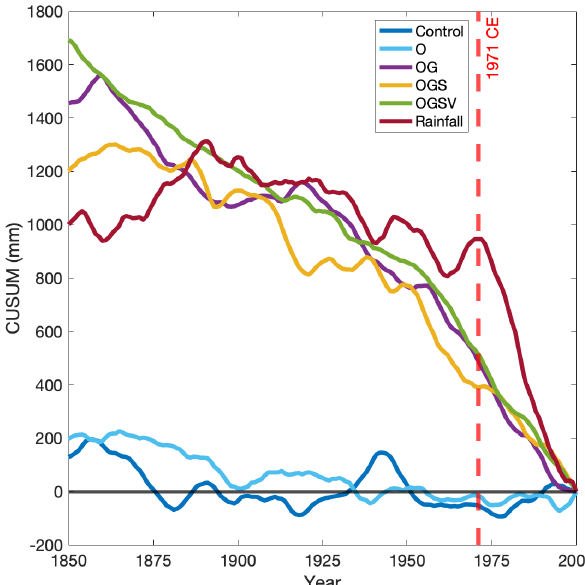
Figure 8. The CUSUM time series for the rainfall reconstruction and simulations for the period from 1972 to 2000CE from the 501– 2000CE series. The black horizontal line represents